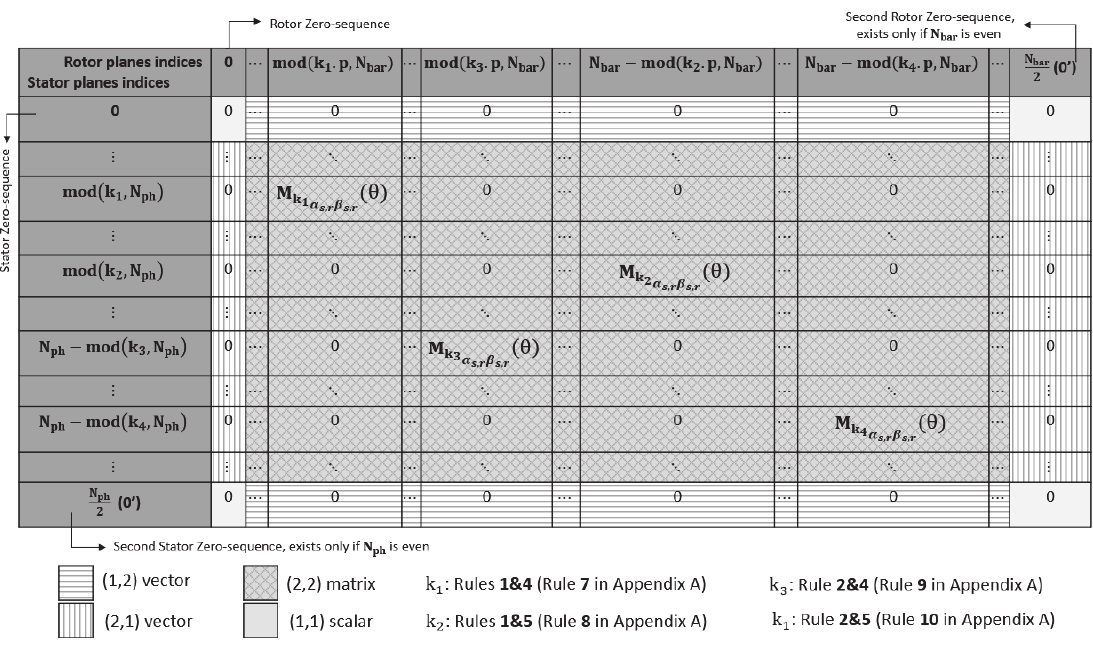
Figure 2. Transformed Stator–Rotor mutual inductance matrix L (cid:2929)(cid:2928)